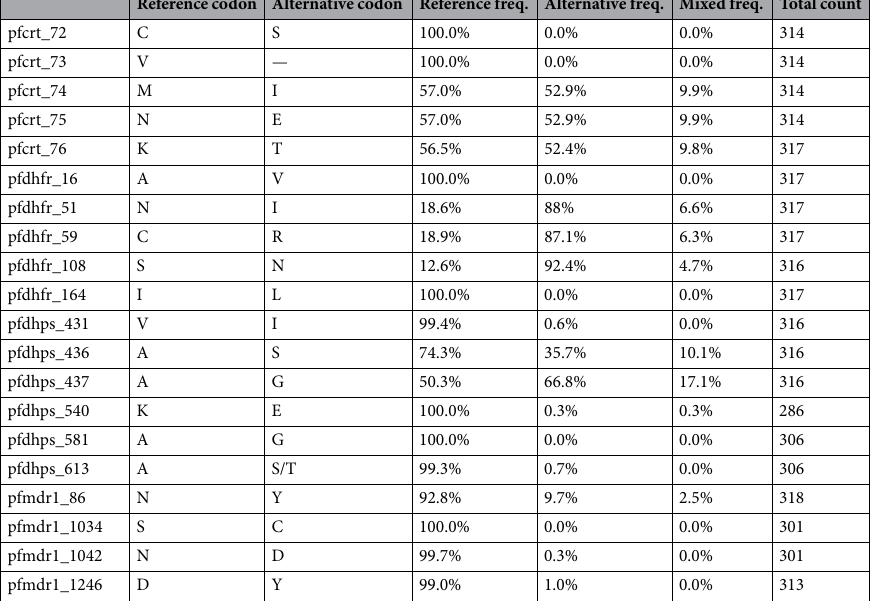
Table 2. Prevalence of resistance-conferring mutations. The table describes what frequencies of the samples that were found to harbor the reference SNPs versus the alternative SNPs (translated into codons) and how many of the samples were categorized as mixed infections. Note that mixed infections (noted as Mixed freq.) were counted in both the reference and alternative frequencies. The analysis was done for every SNP-position of interest in pfcrt , pfmdr1 , pfdhfr and pfdhps .